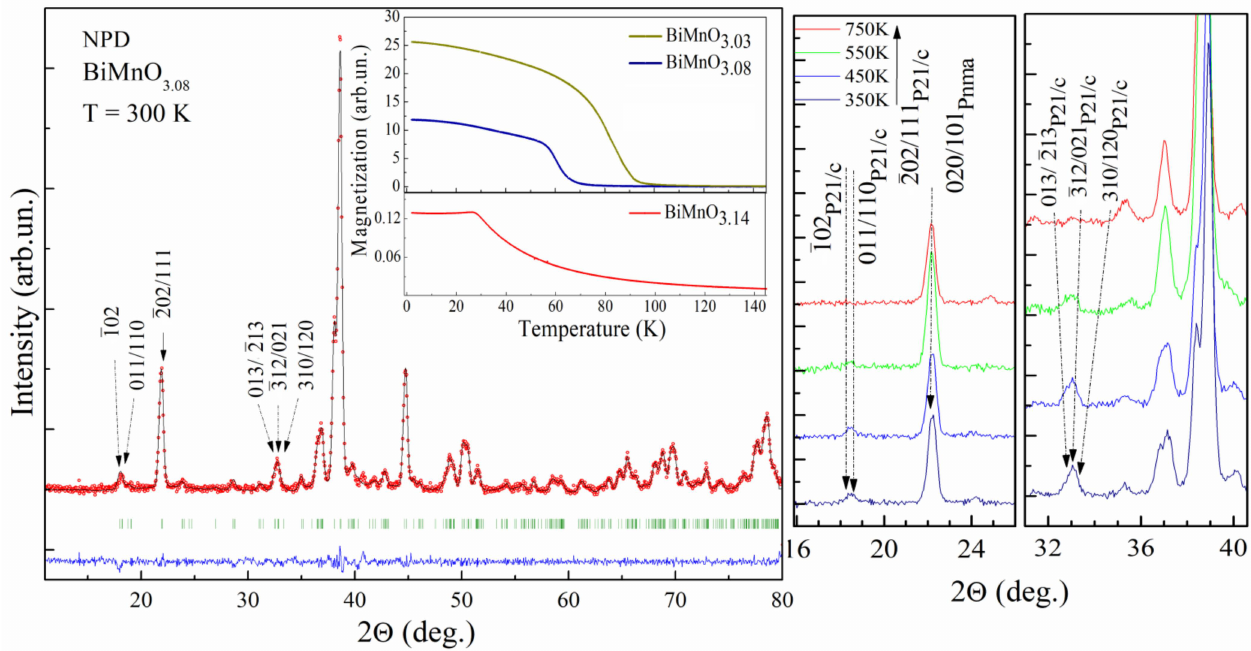
Figure 2. Refined NPD pattern of the compound BiMnO 3.08 using the space group P2 1 /c . Inset shows M(T) magnetization curves for the compounds BiMnO 3+ δ ( δ = 0.02, 0.08, 0.14) measured in a field-cooled mode (H~100 Oe). Images on the right show the temperature evolution of selected NPD reflections of the compound BiMnO 3.08